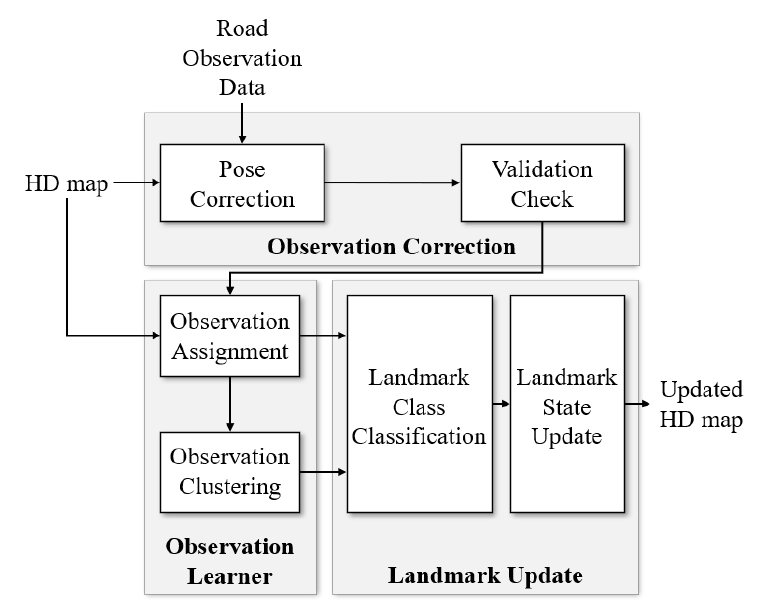
Figure 3. Overview of the HD map update